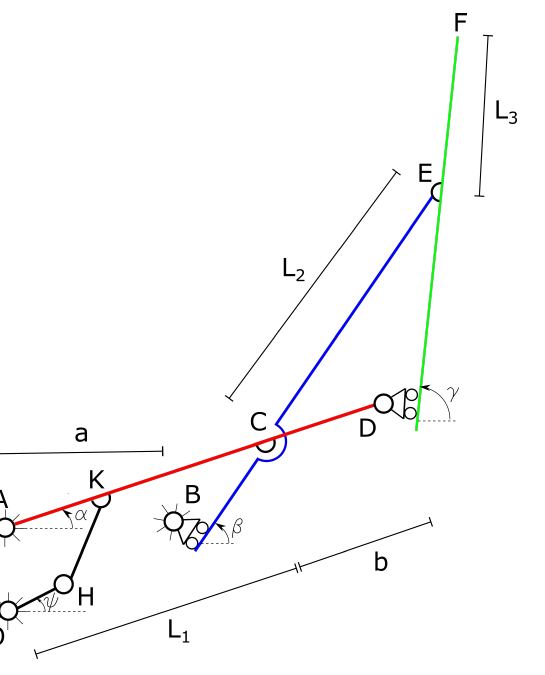
Figure 4. Kinematic scheme of the mechanism actuating the central part of the